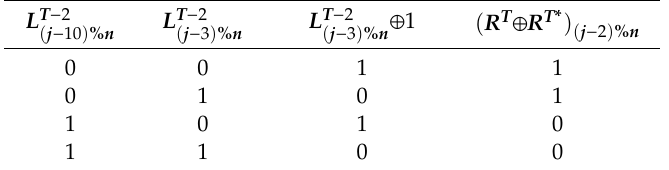
and ( R T ⊕ R T ∗ ) ( j − 2 ) % n ( j − 10 ) % n